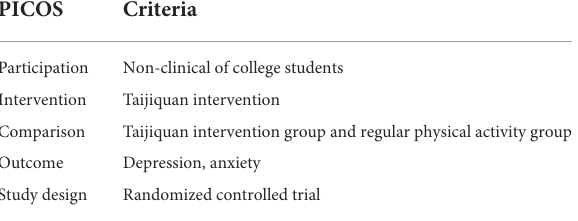
TABLE 1 PICOS-based eligibility criteria (participation, intervention, comparison, outcomes, and study design).